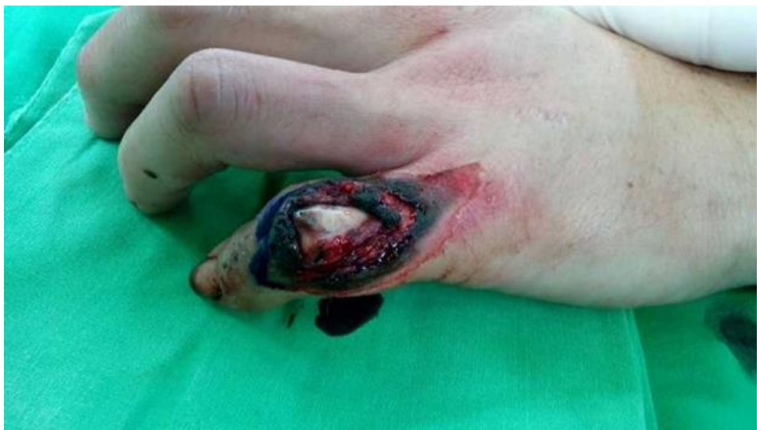
Figure 1. The assumptive scenario in the